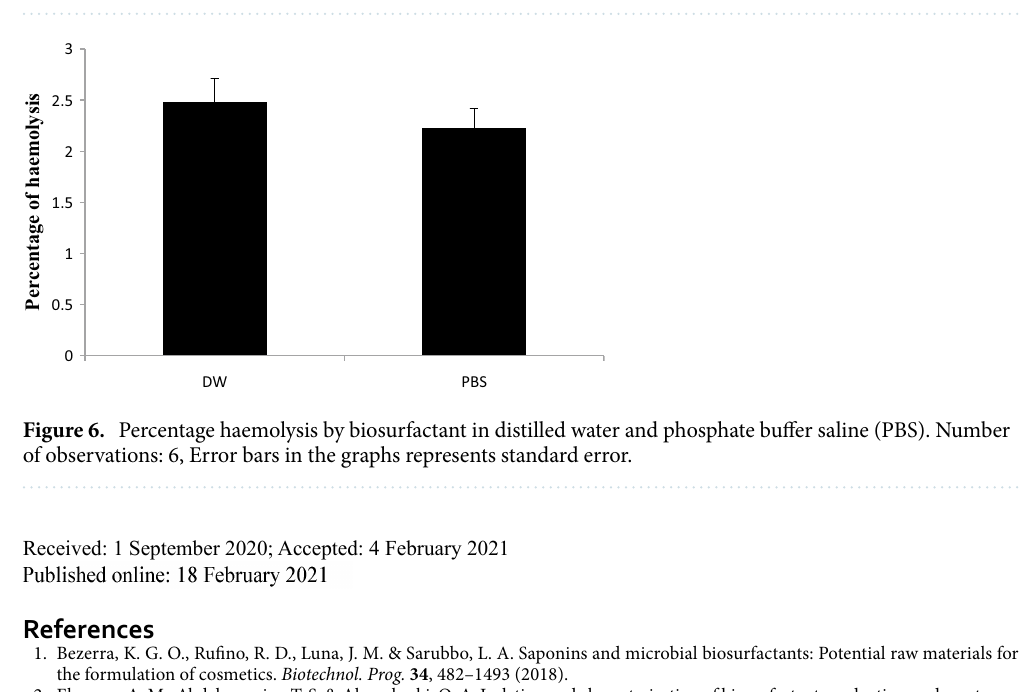
Figure 5. Intracellular ROS analysis by DCFH-Da Fluorescence assay. ( A – C ) Biosurfactant. ( A ) Wild control group. ( B ) cells treated with 50 µg/mL for 6 h and ( C ) 50 µg/mL for 10 h. ( D – F ) Decolorized biosurfactant. ( D ) Wild control group. ( E ) Cells treated with 50 µg/mL for 6 h and (F) 50 µg/mL for 10 h. Intensity based histogram (as calculated by image J) is presented in inset for each treatment.